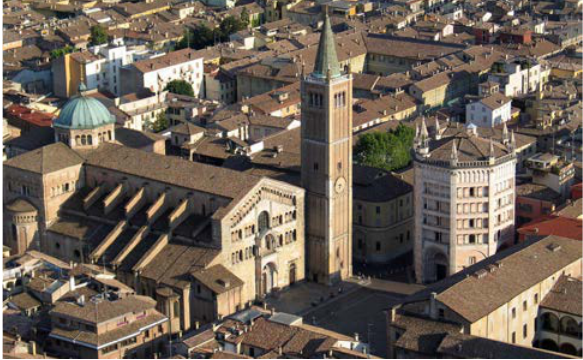
Figure 2_The Parma Cathedral. From: